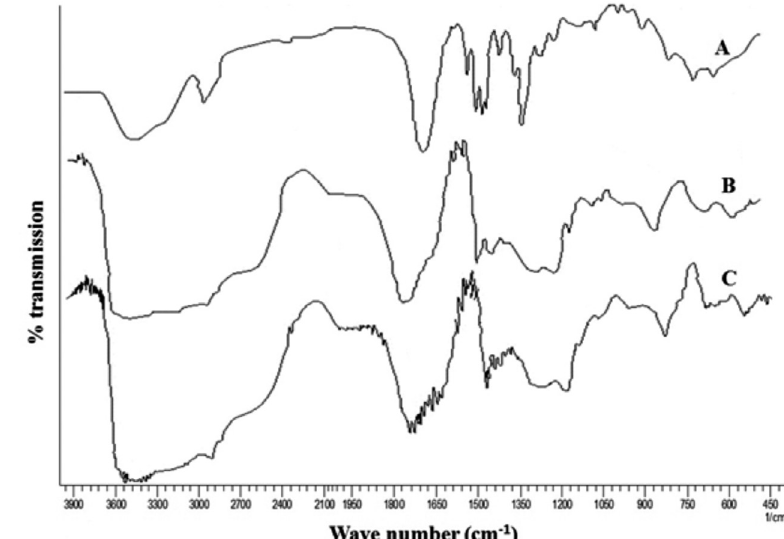
FIGURE 2 - FTIR spectra (A) PVP (B) acrylic acid (C) PVP/AA hydrogel